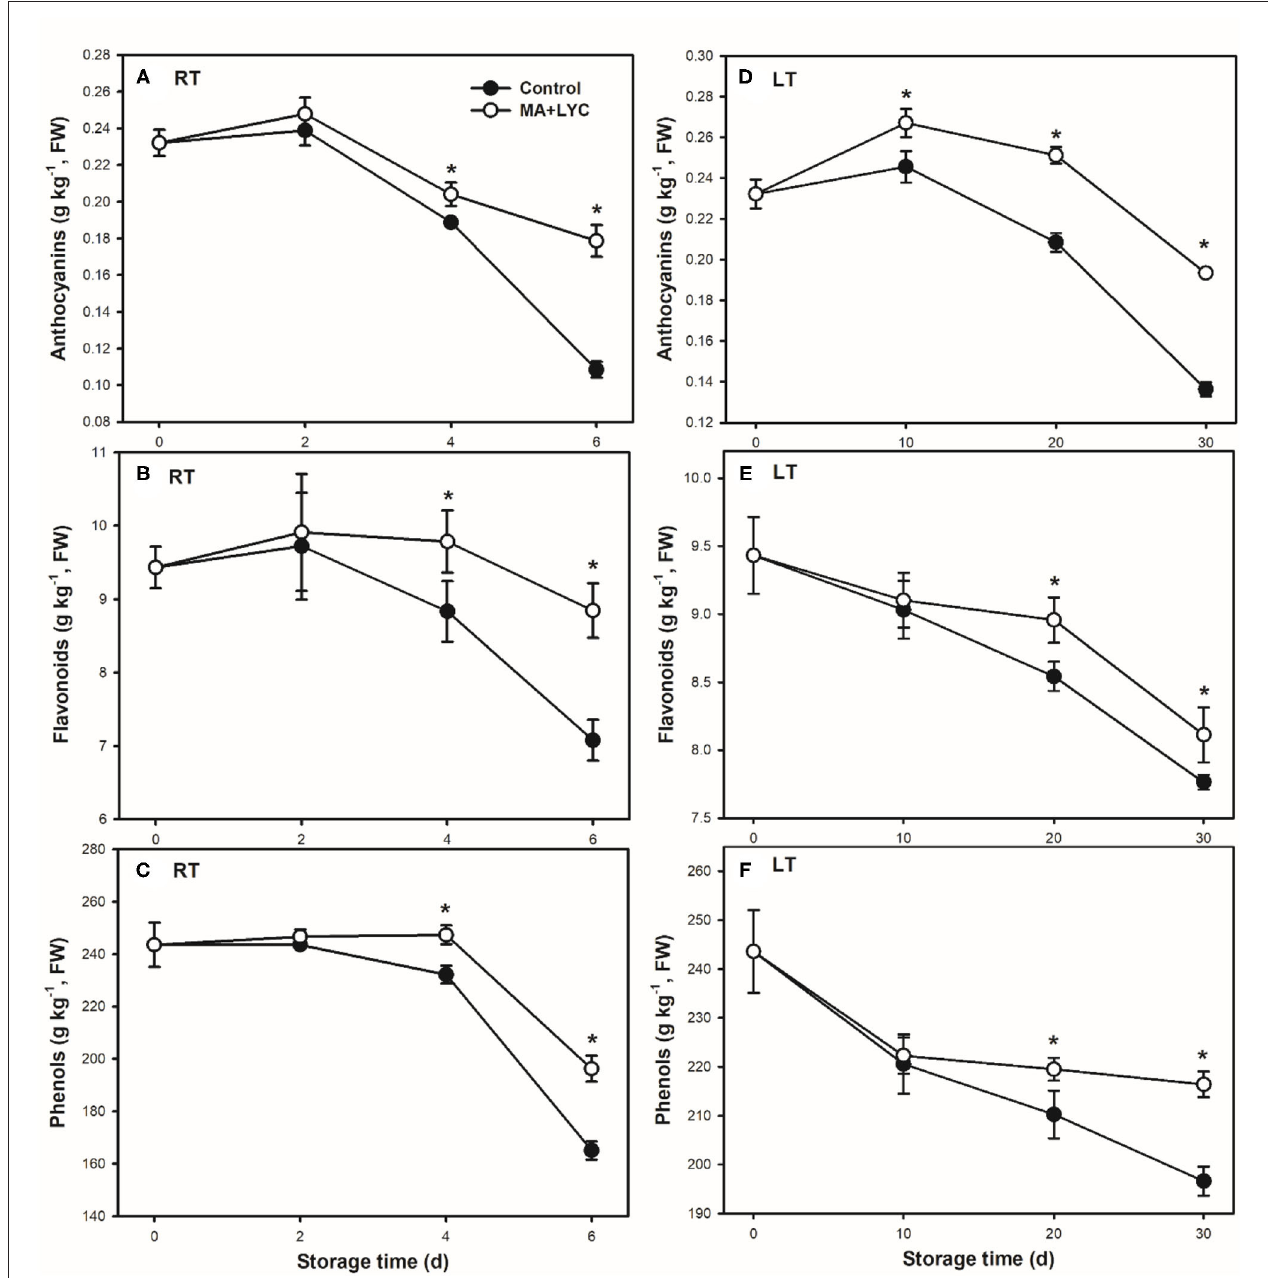
FIGURE 3 | The content of polyphenols changes following the ripening and senescence of litchi fruit during storage. (A,B) The content of anthocyanins; (C,D) are the content of flavonoids; and (E,F) are the content of total phenols stored at RT (25 ◦ C) and LT (4 ◦ C), respectively. Data are represented by mean values with the SD. Asterisk indicates the significant difference of means at 0.05